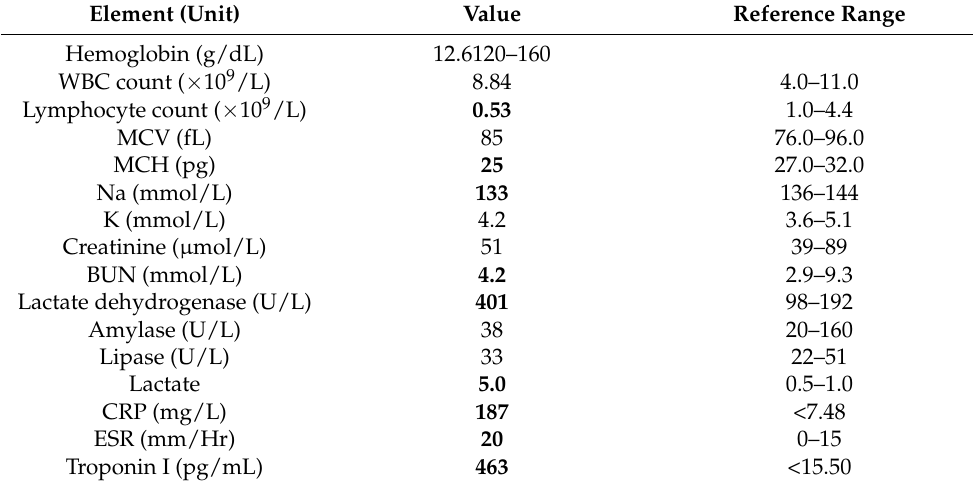
Table 3. Summary of the laboratory investigations of the third